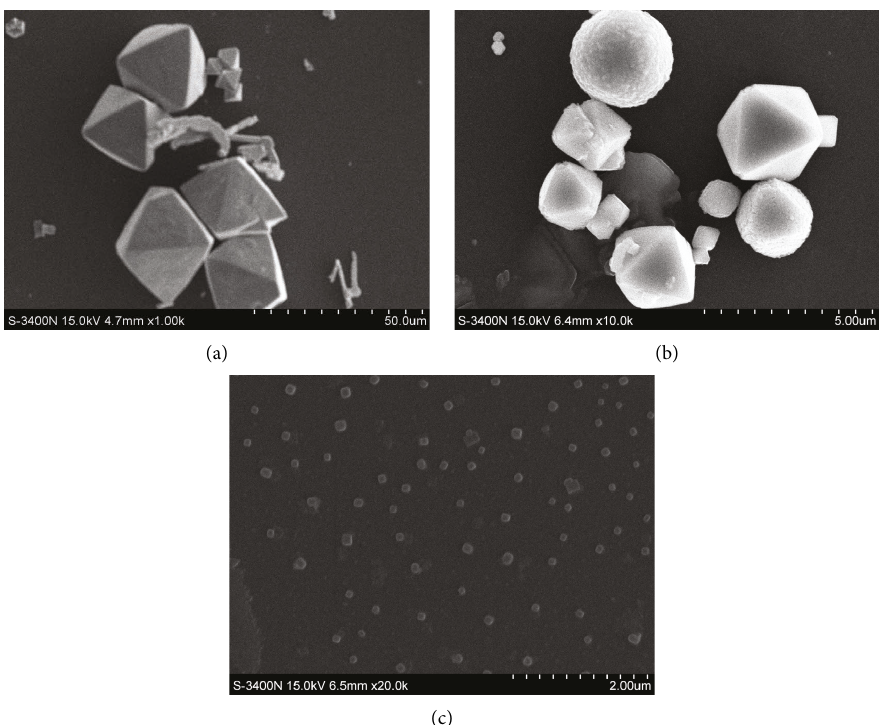
Figure 4: SEM images of the Cu 2 O particles prepared with different PVP dosages: (a) 0 g,(b) 0.50 g, and (c) 5.00g.